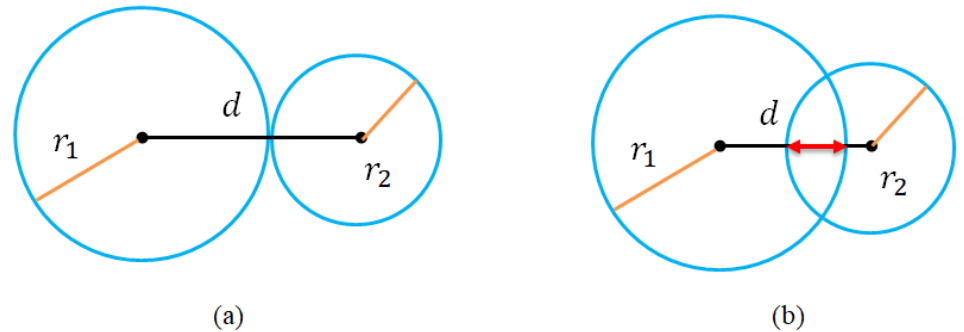
Figure 4. The relationship between two spheres shown in 2D. ( a ) The two spheres are tangential; ( b ) the two spheres overlap.